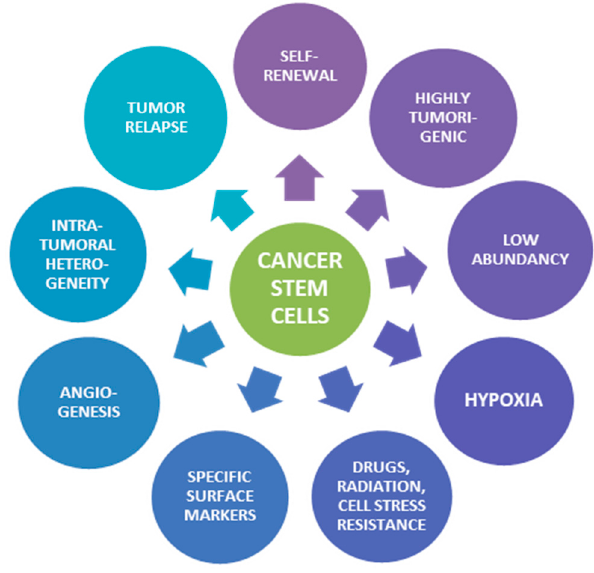
Figure 1. Characteristics of Cancer Stem